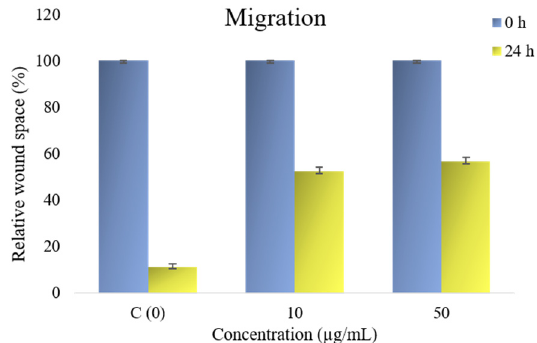
Figure 2. Effects of LSE on the migration of the HeLa cell line. Analysis of wound space is shown as relative level of changes in wound space width. Results are presented as means ± standard error.